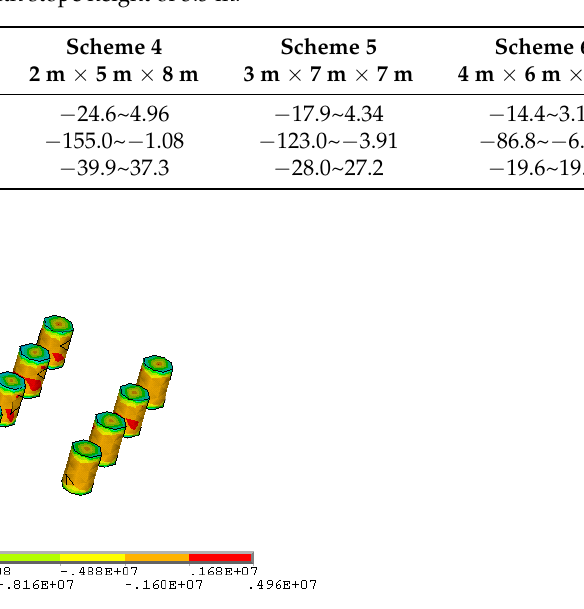
Figure 23. Maximum principal stress distribution of scheme 4 pillars at 1480 mL (parameters of scheme 4: stope height 3.5 m, pillar diameter 2 m, pillar spacing 5 m, pillar row spacing 8 m).